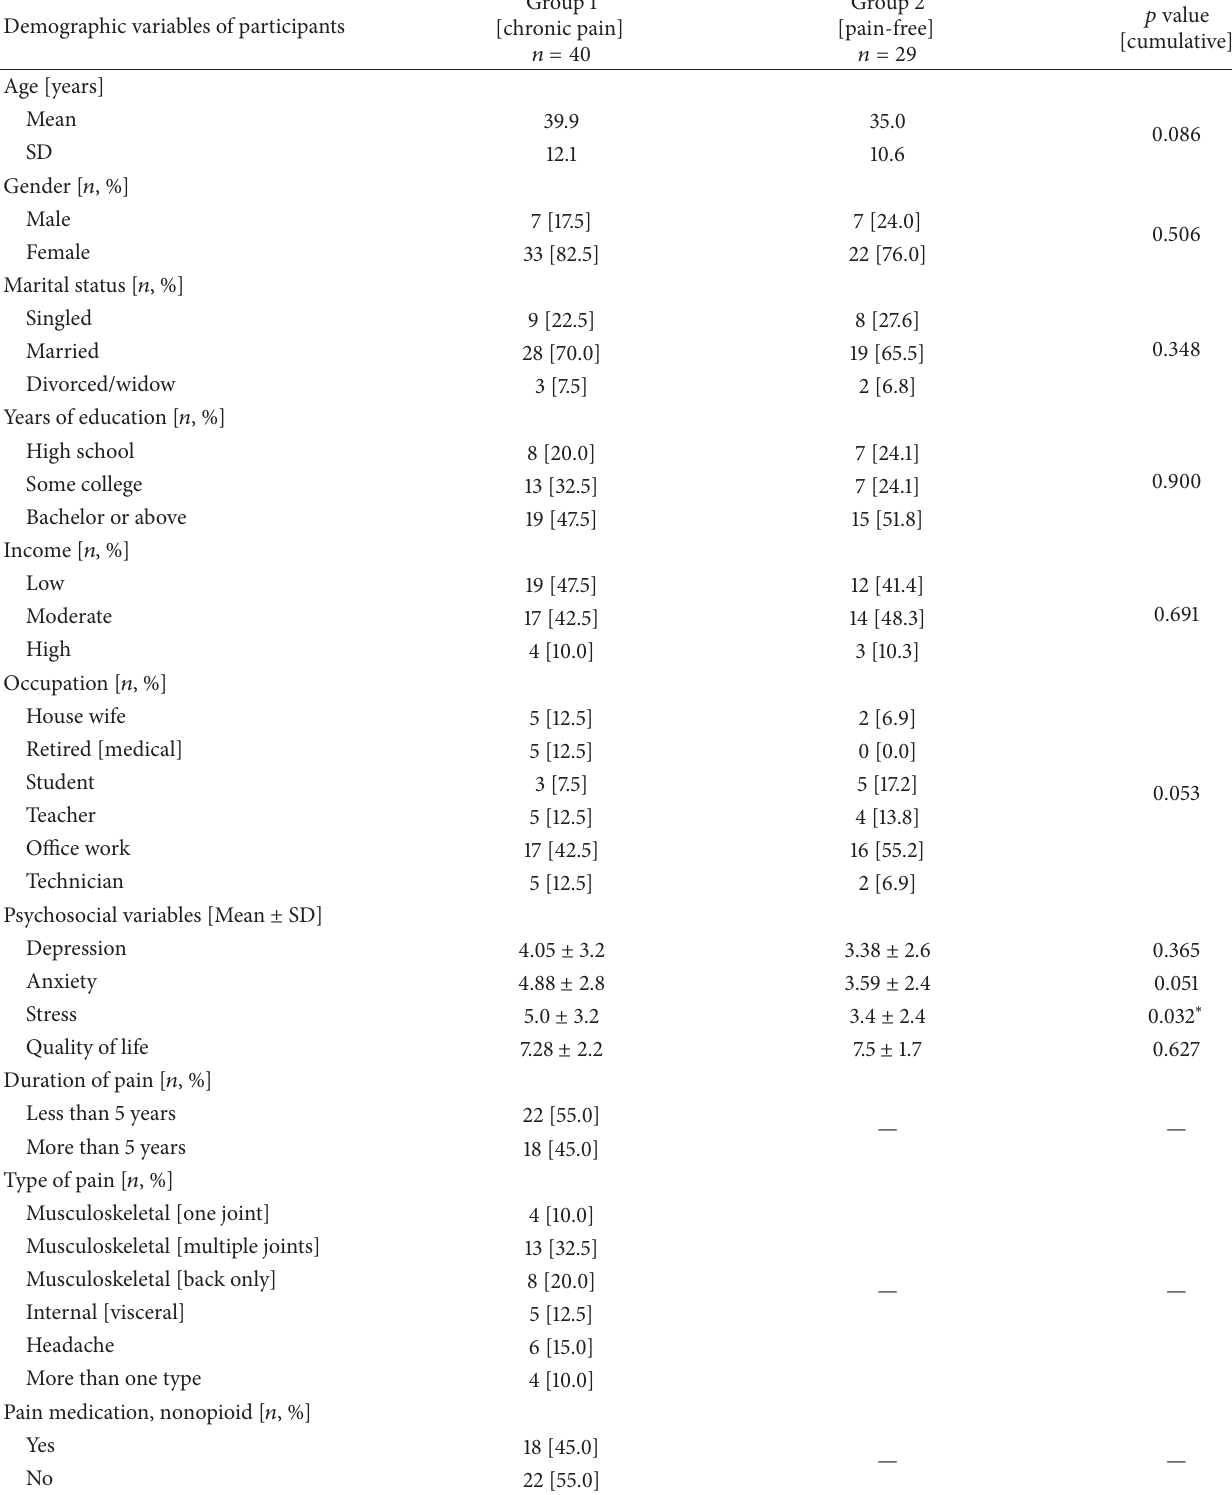
Table 2: Demographic and individual variables of the